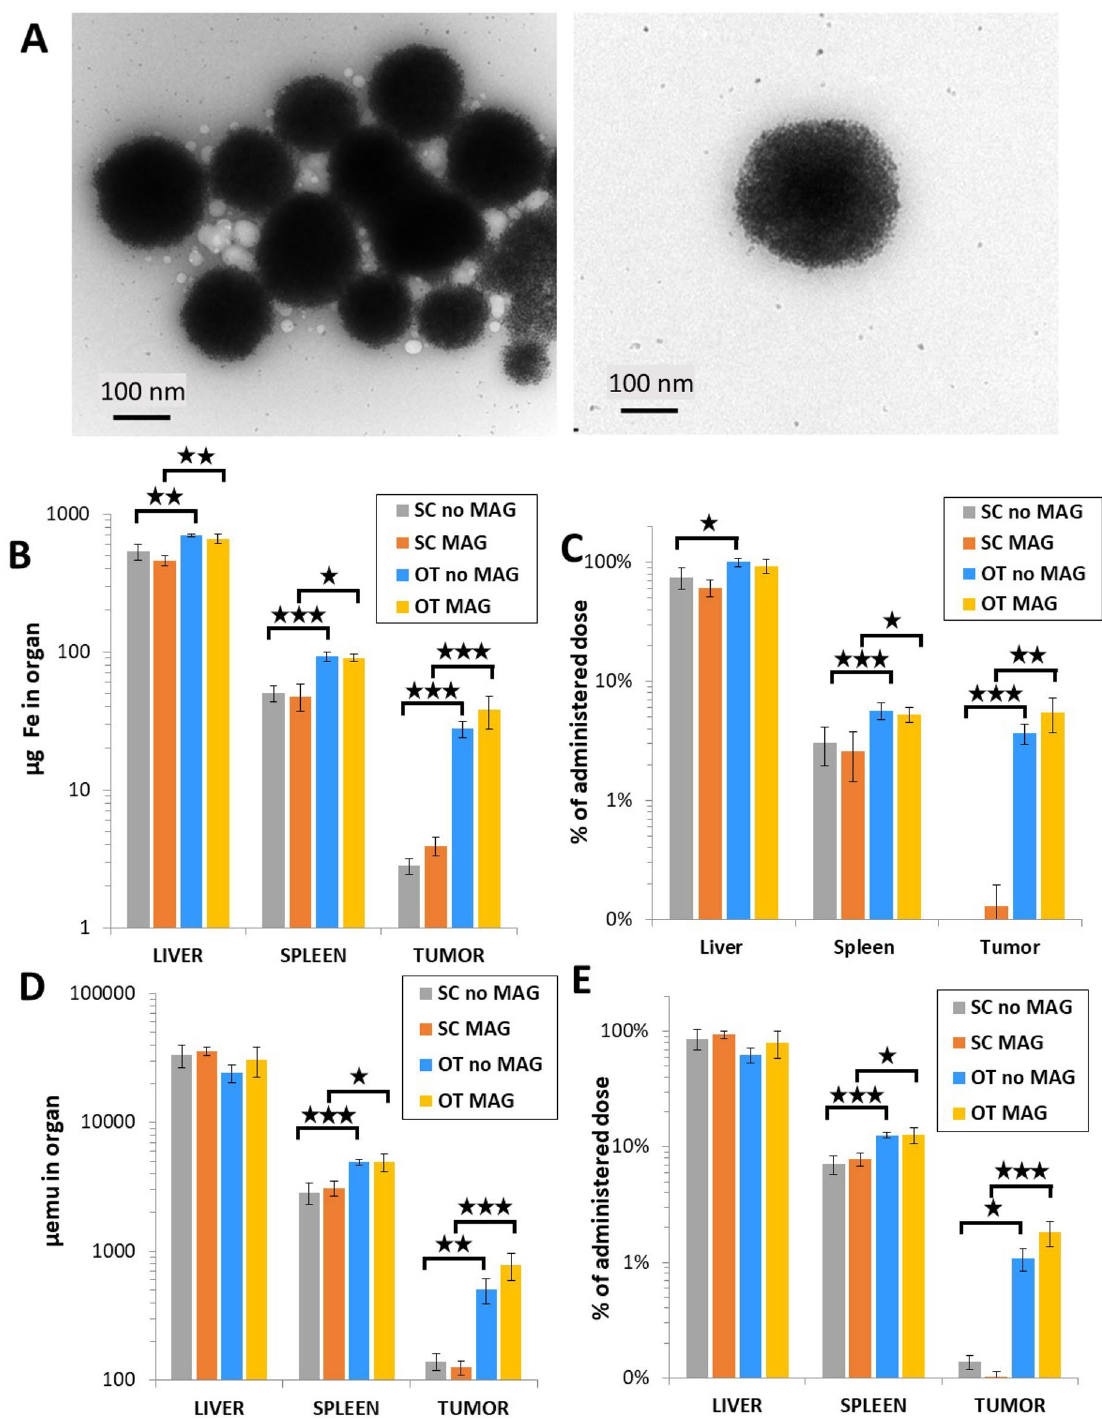
Figure 2. Quantification in organs after ultramagnetic liposomes intravenous administration. ( A ) Transmission electron microscopy micrographs showing the structure of the ultramagnetic liposomes. ( B ) and ( C ) Mass of iron and percentage of the administered total mass of iron, respectively, measured in the liver, spleen and the two tumor models with and without magnet application. ( D ) and ( E ) Magnetic moment (expressed in µemu) and percentage of the administered dose in terms of magnetic moment, respectively, measured under the same conditions. The percentage of the administered dose was calculated as the total content in each organ subtracted by the same for control, normalized by the dose injected (558 µg of iron/mouse) for total iron content ( D ) and for emu (E). * p < 0.05, ** p < 0.01 and *** p <